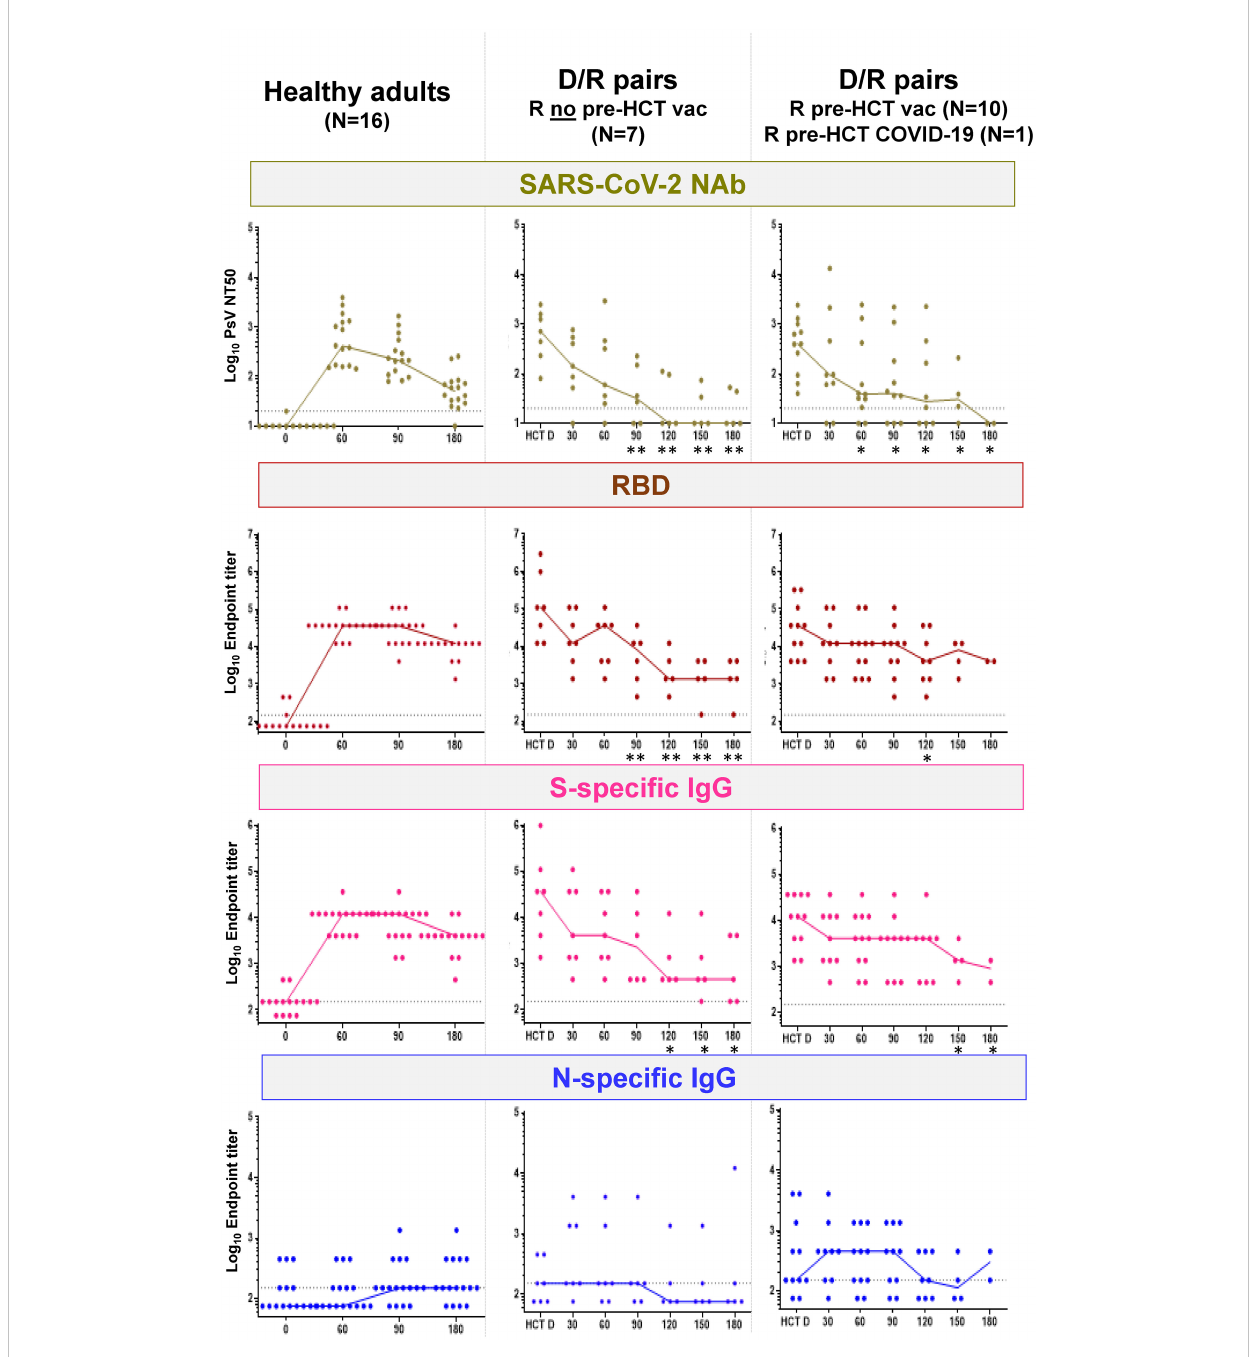
FIGURE 3 SARS-CoV-2-speci fi c humoral responses. Left plots, SARS-CoV-2 NAb, RBD, and S- and N-speci fi c IgG (as speci fi ed in the top plot banners) in healthy adults before BNT162b2 mRNA COVID-19 vaccine (reported as 0, in the x -axis), and afterwards at the time points shown in the x -axis (days 60, 90, and 180). Middle and right plots, SARS-CoV-2 NAb, RBD-, and S- and N-speci fi c IgG (as speci fi ed in the top plot banners) for D/R pairs in whom R did not receive a licensed COVID-19 vaccine before HCT ( N = 7; middle plots) and D/R pairs in whom R received a licensed COVID-19 vaccine before HCT ( N = 10) or had a history of COVID-19 infection before HCT ( N = 1; right plots). In the x -axis, HCT D indicates the donor response in serum obtained at least 30 days before granulocyte colony-stimulating factor for peripheral blood CD34 + cell apheresis collection; time points 30, 60, 90, 120, and 180 indicate the days post-HCT in which recipient serum specimens were analyzed. Star symbols on the post-HCT day indicate that differences in humoral responses (NAb, RBD, and S- and N-speci fi c IgG) between HCT donors and recipients were signi fi cant (* p < 0.05 and ** p < 0.01, calculated by Mann – Whitney U test). SARS-CoV-2-neutralizing antibodies (NAb) are expressed on the log 10 y -axis as serum dilution that neutralized 50% of the SARS-CoV-2 pseudovirus (PsV NT50). RBD and S- and N-speci fi c IgG were measured using indirect ELISA and are expressed on the log 10 y -axis as endpoint titers. Responses at time points after post-HCT COVID-19 vaccination, COVID-19 diagnosis, and administration of COVID-19 monoclonal antibody products were not included in the plots. Speci fi cally, for R who did not receive a licensed COVID-19 vaccine before HCT (middle plots), the following are the sera tested at each time point: day 30, N = 7; day 60, N = 7; day 90, N = 6; day 120, N = 5; day 150, N = 5; and day 180, N = 5. For R who received a licensed COVID-19 vaccine before HCT or had a history of COVID-19 infection before HCT (right plots), the following are the sera tested at each time point: day 30, N = 9; day 60, N = 11; day 90, N = 10; day 120, N = 8; day 150, N = 4; and day 180, N =